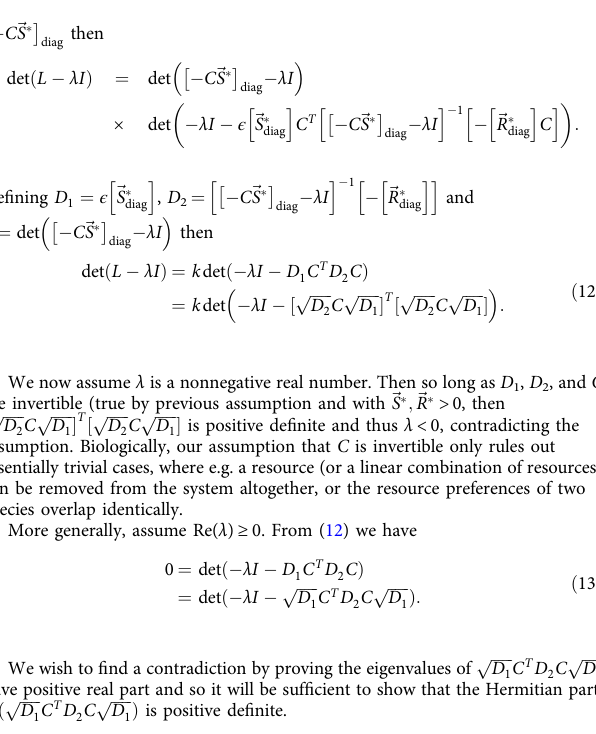
ffiffiffiffiffiffiffiffiffiffiffiffiffiffi p ¼ Re D 2 ð Þ